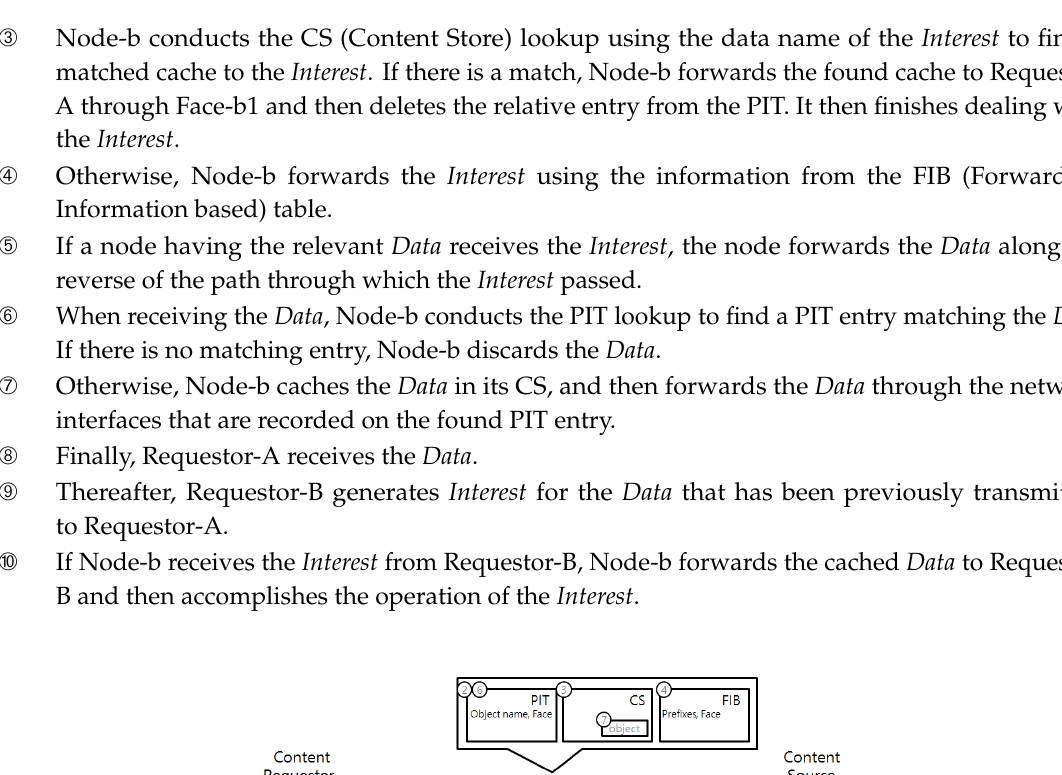
Figure 1. Data networking architecture (NDN) Interest/Data Procedure.